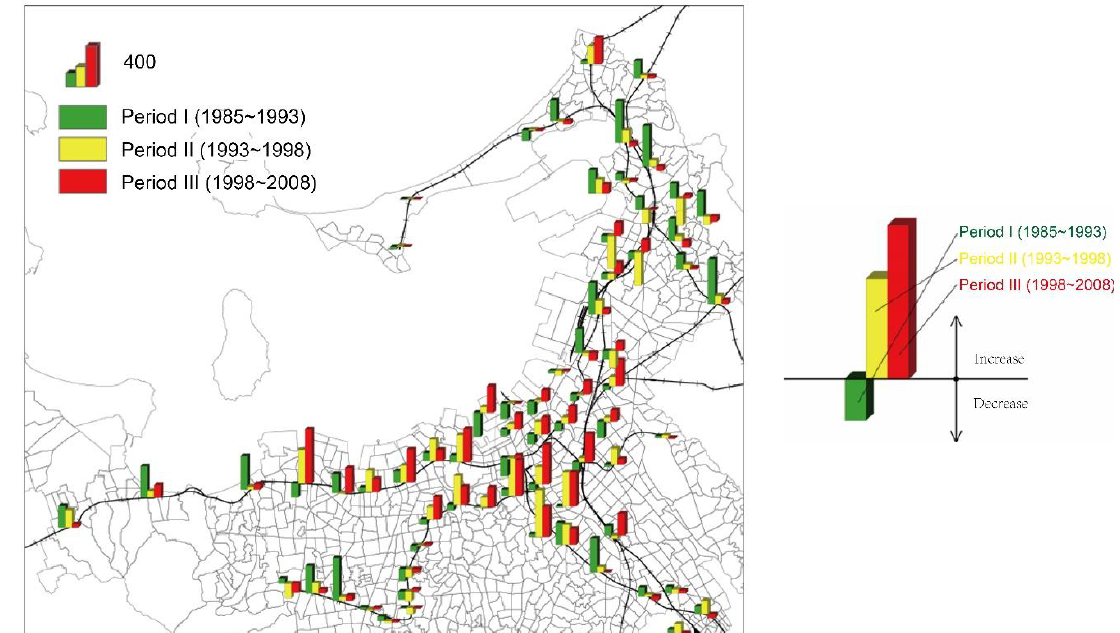
Figure 4. Population changes in station zones (average annual